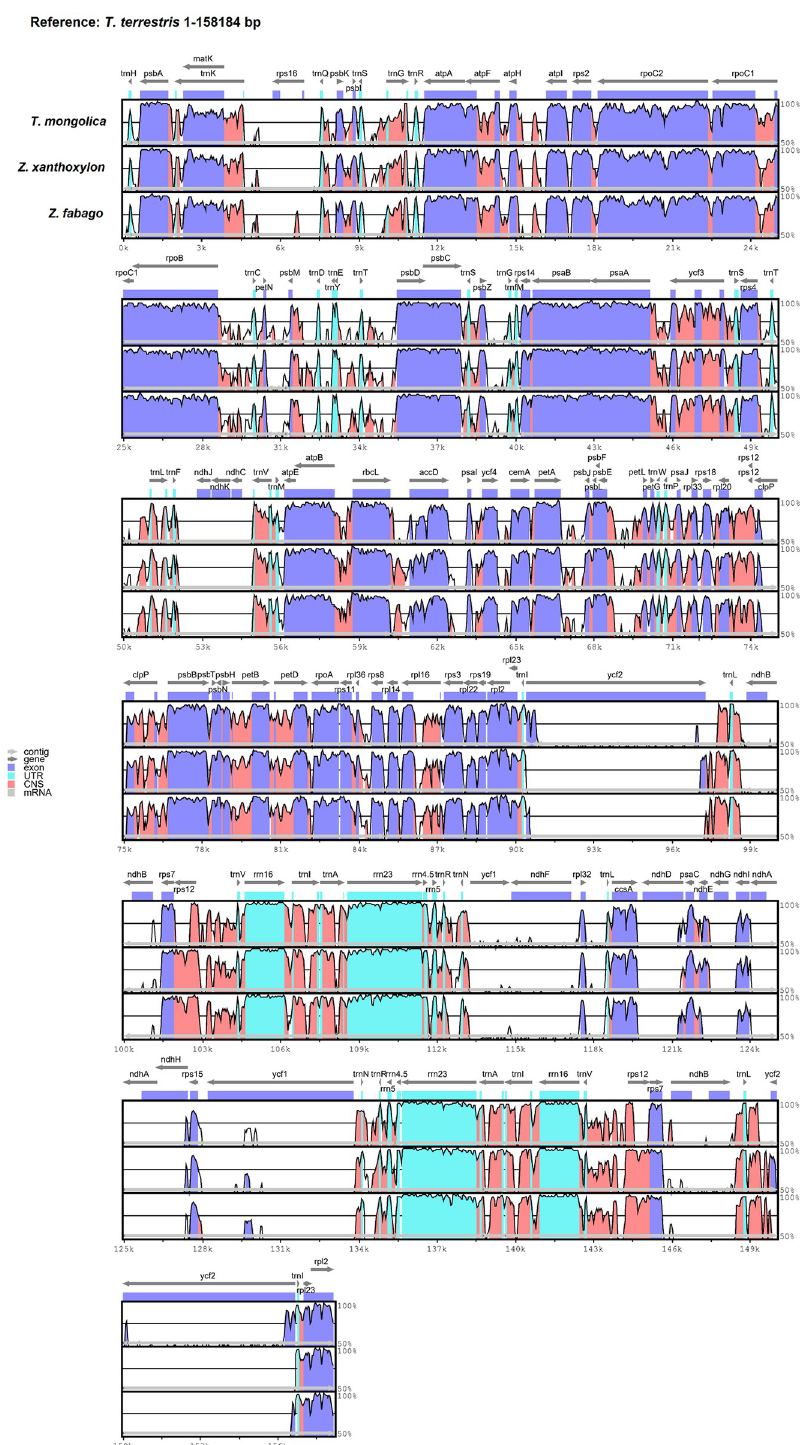
Fig 8. Comparison of the three chloroplast genomes utilizing T . terrestris as reference. Gray arrows and thick black lines above the alignment represent gene direction. Purple bars show exons, sky-blue bars show transfer RNA (tRNA) and ribosomal RNA (rRNA), red bars show non-coding sequences (CNS) and white peaks show the differences between chloroplast genomes. The y-axis indicates the identity percentage ranging from 50 to 100%.